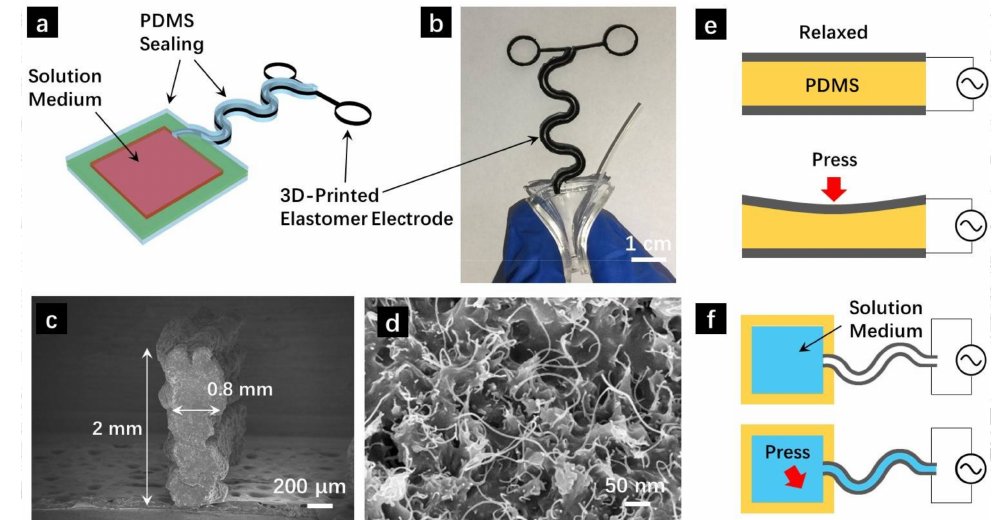
Figure 1. ( a ) Schematic diagram of the 3D printed capillary pressure sensors; ( b ) Photograph of the sensor showing soft PDMS solution pool; ( c ) Cross-sectional SEM image of the conductive elastomer electrode; ( d ) High-magnification SEM showing the uniform CNT distribution within the PDMS matrix; Structure and sensing mechanism of ( e ) conventional pressure sensor through the change of interspace between parallel electrodes and ( f ) our capillary pressure sensors through the change of dielectric